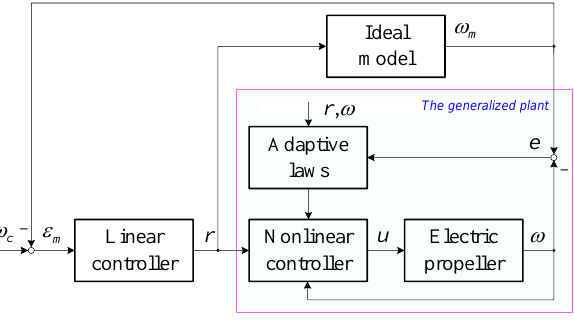
Figure 3. The nonlinear adaptive control diagram.